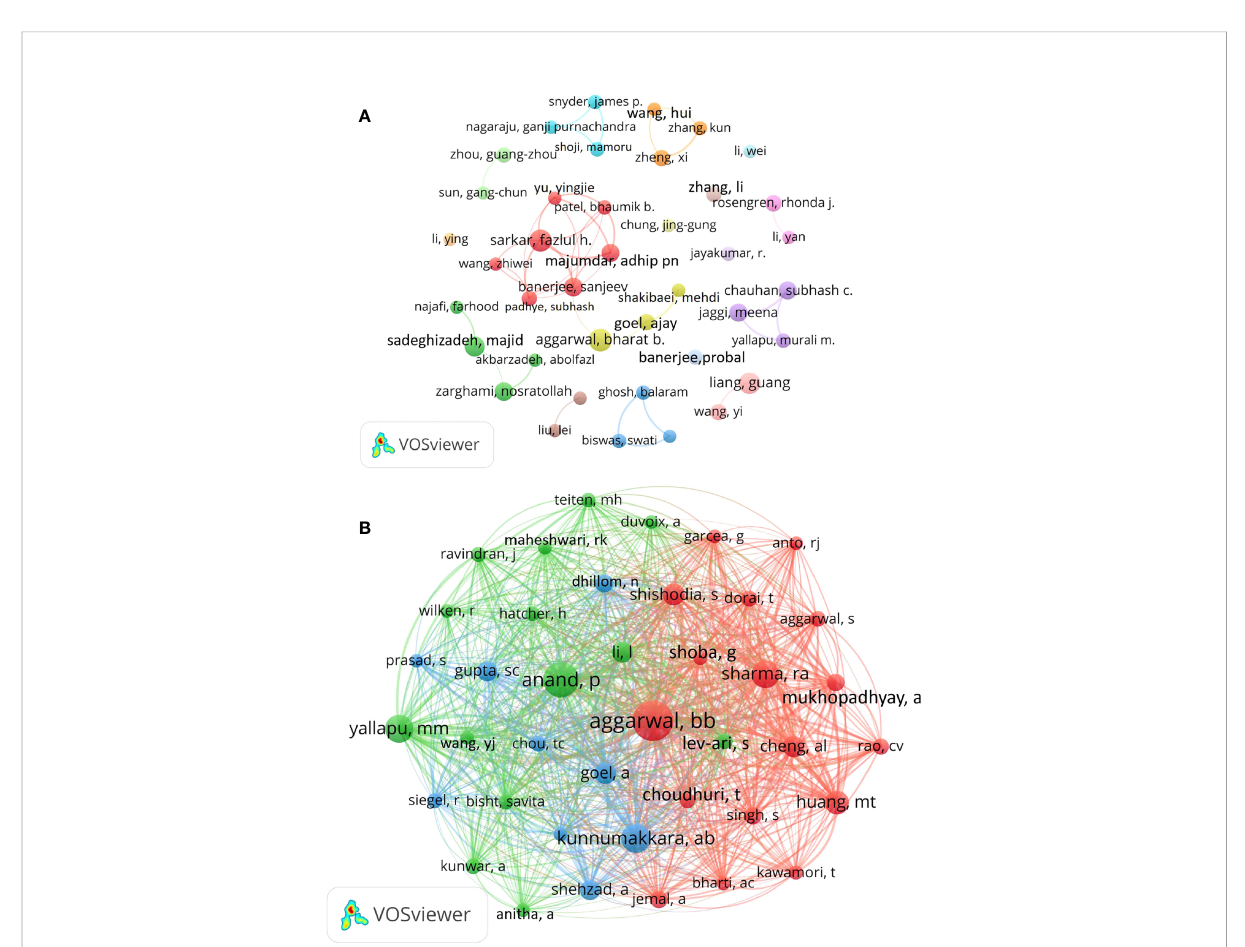
FIGURE 6 Visualization of active authors analysis. (A) Network visualization analysis of author collaboration. (B) Network visualization map of co-cited authors of the